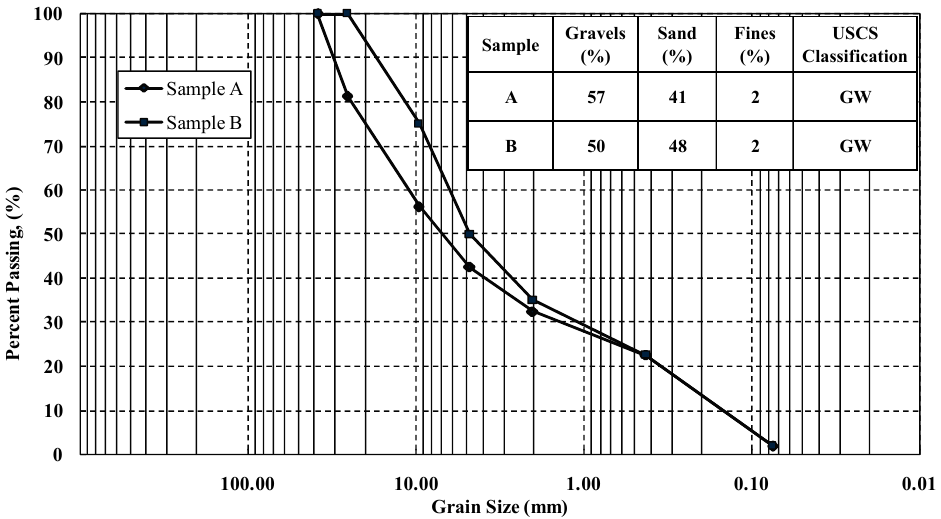
Figure 1. Gradations for the sub-base samples.